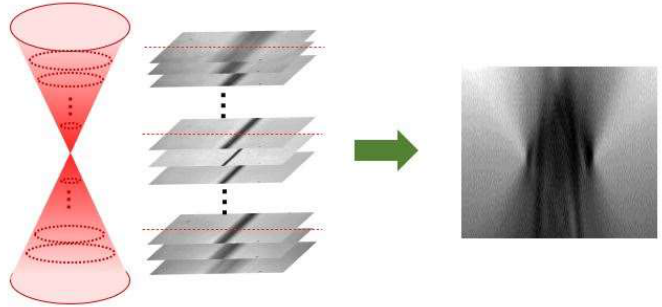
Figure 3. Process to construct a TSOM image.